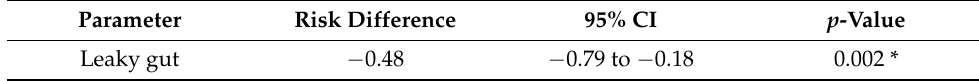
Table 5. Risk difference analysis of probiotics treatment.